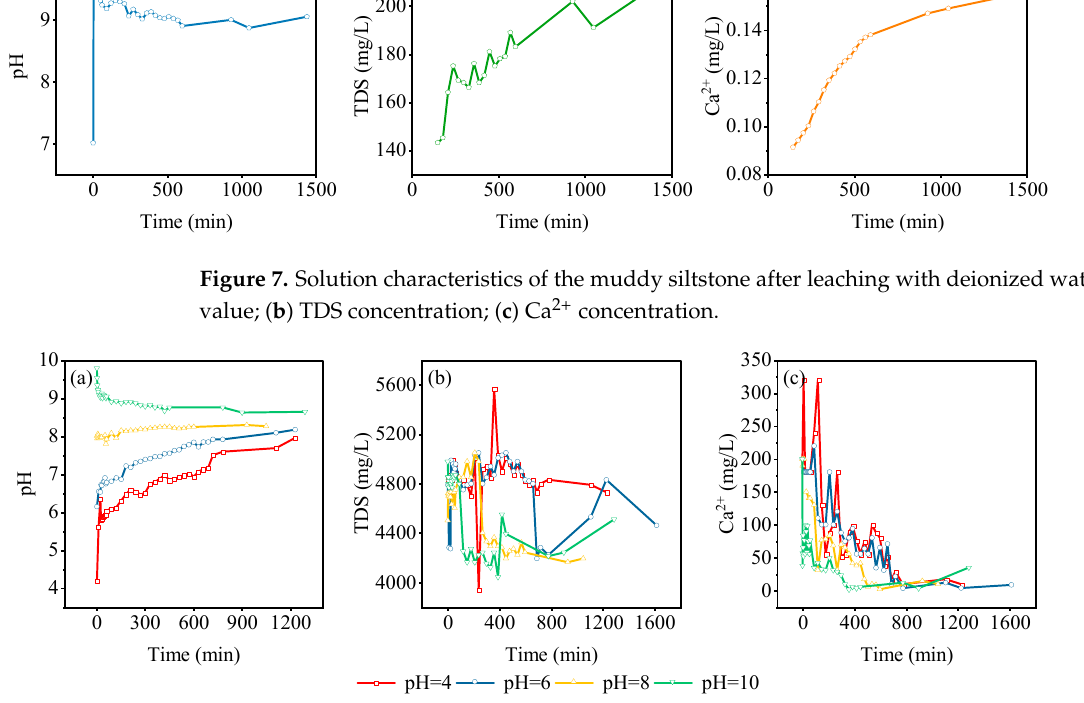
Figure 8. Solution characteristics of muddy siltstone leached by mine water at different pH values: ( a ) pH value; ( b ) TDS concentration; ( c ) Ca 2+ concentration